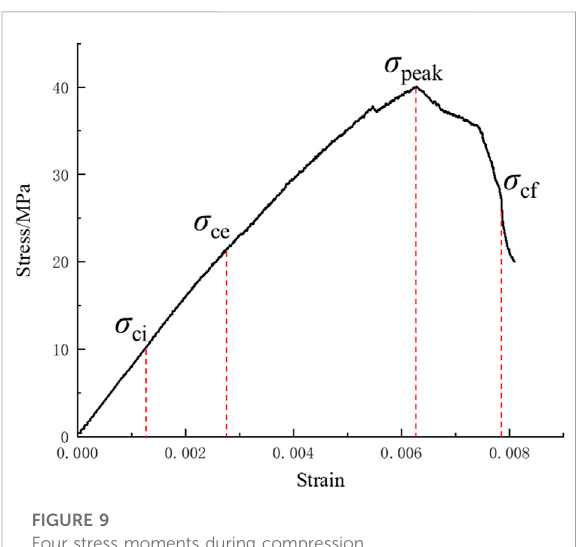
FIGURE 9 Four stress moments during